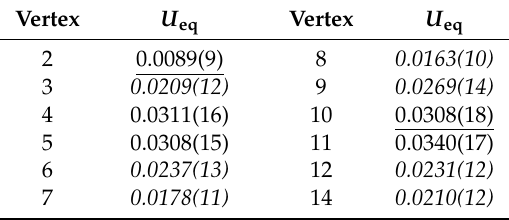
Table 1. U eq values (/Å 2 ) for non-metal vertices in Prostructure of [1,13-Cp 2 - closo -1,13,2,10- Co 2 C 2 B 10 H 12 ]. Vertex U eq Vertex U eq 2